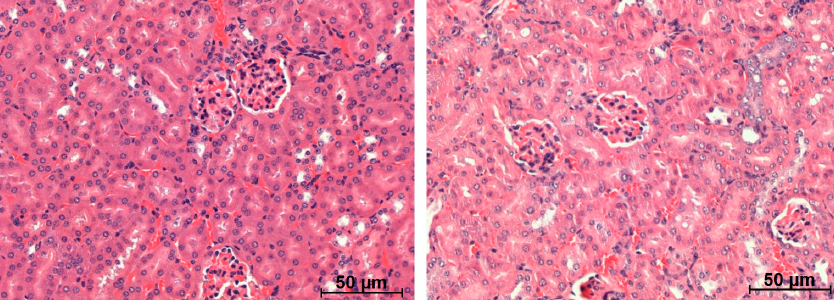
Figure 5. Representative histological images (×20 magnification) of kidneys of BALB/c mice 12 months after administration of saline (left) or 0.33 MBq of 212 Pb-NG001 (right).